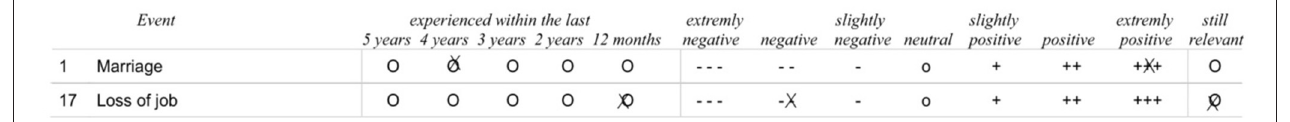
FIGURE 4 | Inductory illustrative examples for the subsequently presented list of life-events.